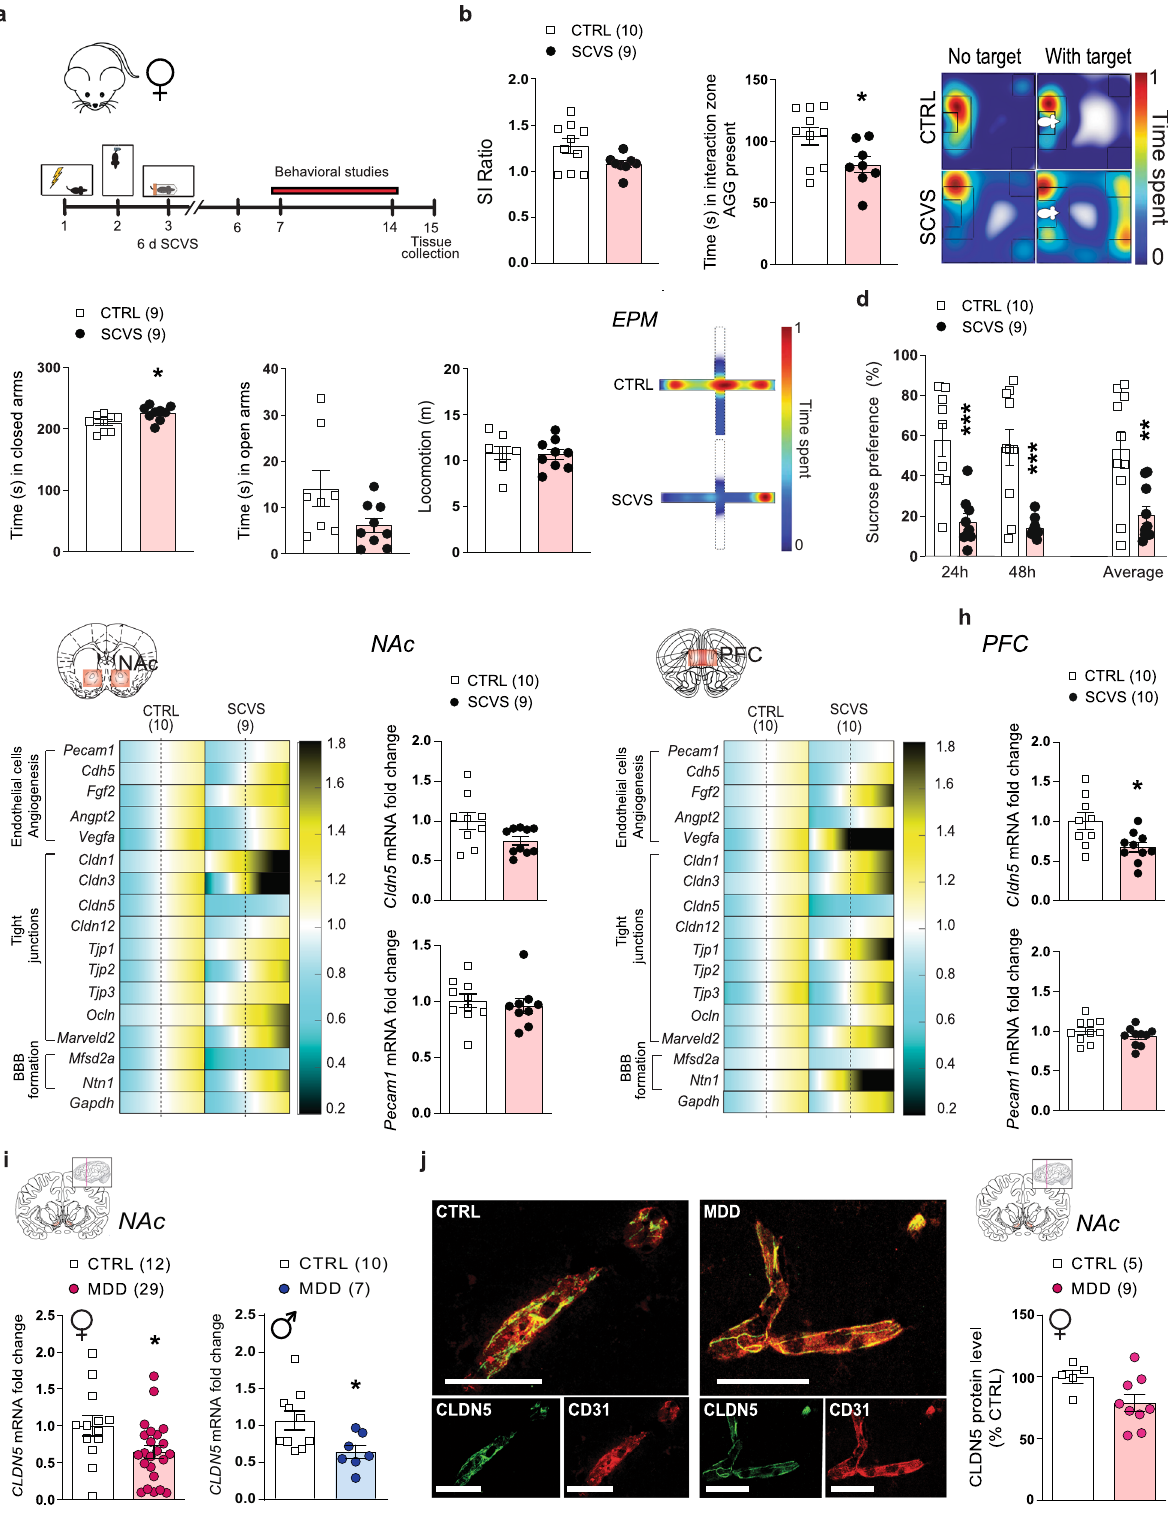
unstressed CTRL (Fig. 4c). These fi ndings con fi rm that chronic social stress induces BBB adaptations underlying individual dif- ferences in stress responses. Analysis of biological pathways dif- ferentially regulated between PFC endothelial cells of SS vs CTRL female mice revealed increased expression of genes associated with oxidative damage while omega-3/omega-6 fatty acid synth- esis was linked with resilience (Fig. 4d). Glial cell line-derived